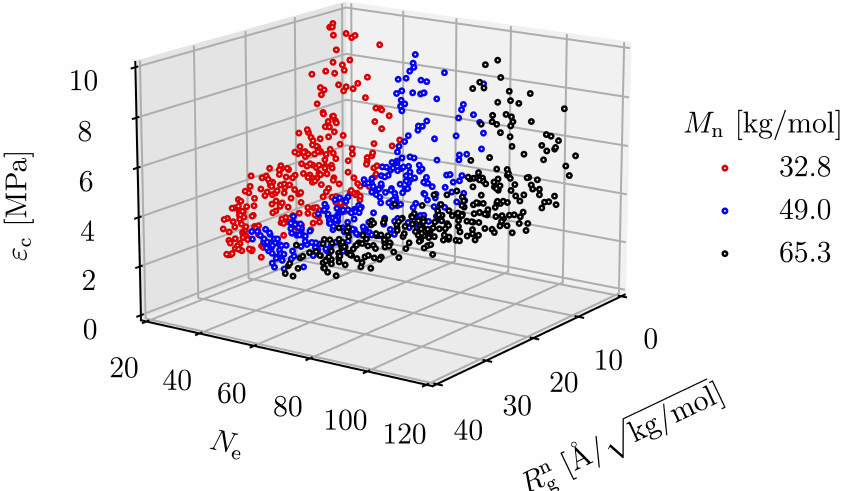
Figure 16. ε c as a function of R n g and N e